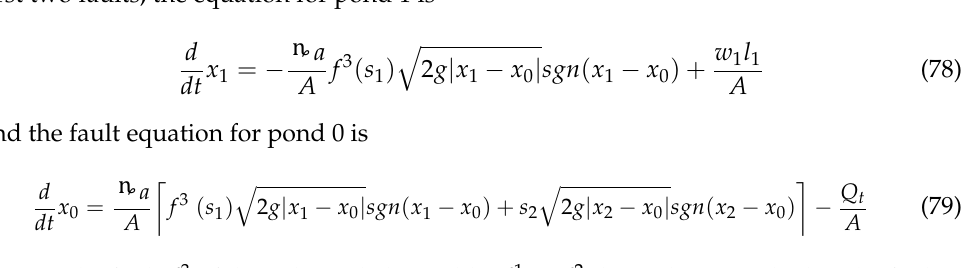
Figure 1. Three-pond hydraulic system.